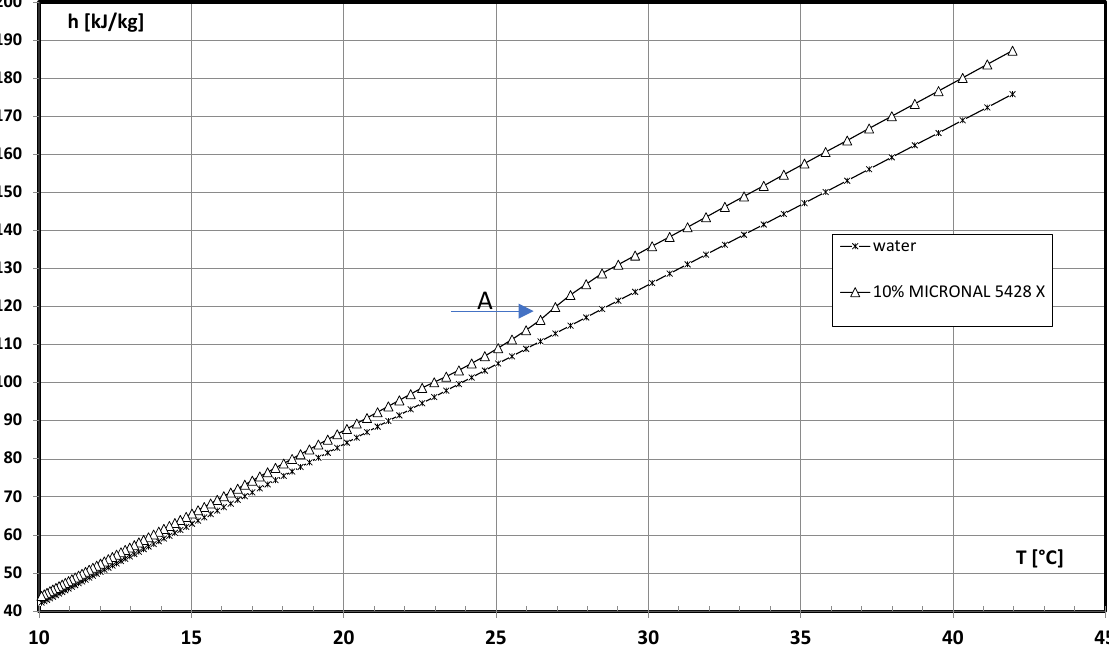
Table 1. The measuring equipment uncertainty.